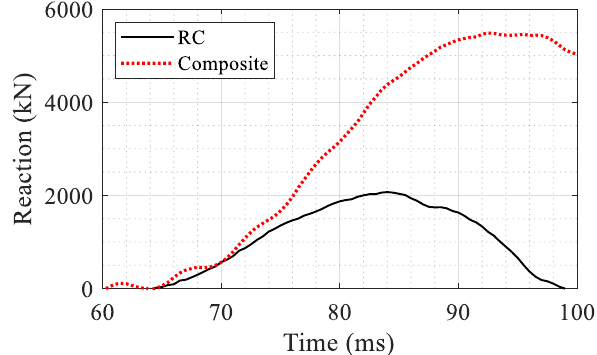
Figure 21. Comparison of the residual axial capacity of the blast damaged columns.